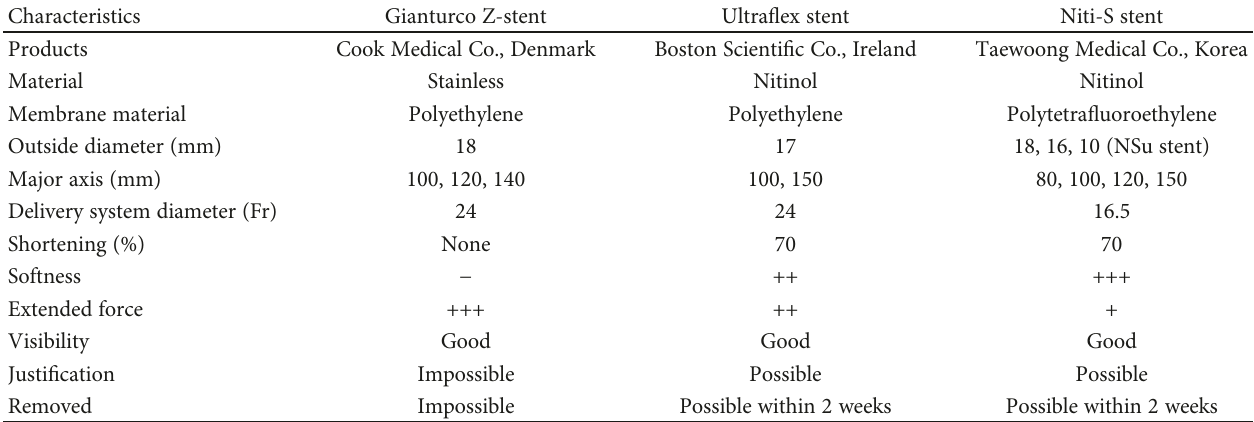
Table 1: Self-expandable metallic stent characteristics.